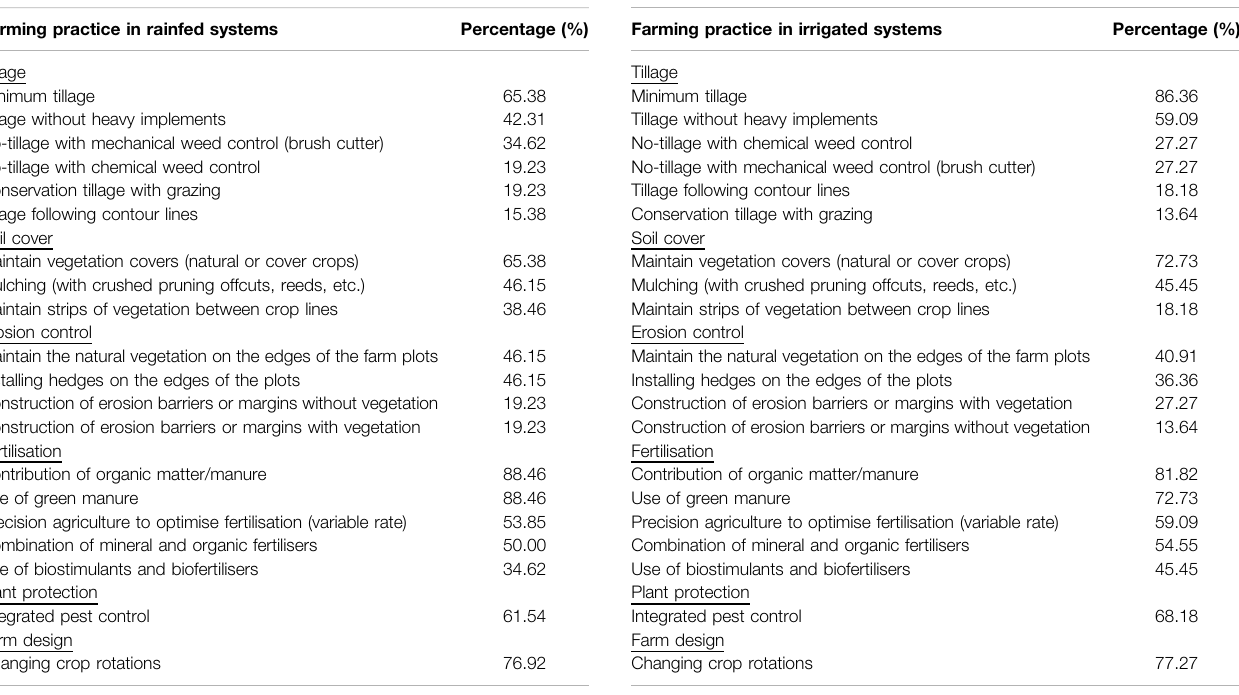
TABLE 5 | Identi fi cation of adequate farming practices for rainfed cereal-based cropping systems, listed in a decreasing order. For each practice, values refer to the percentage of stakeholders that identi fi ed it suitable.